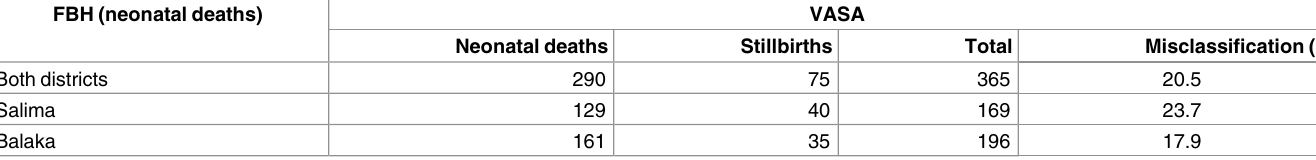
Table 2. Percent of stillbirths misclassified by FBH as neonatal deaths, by district in Malawi. FBH (neonatal deaths)